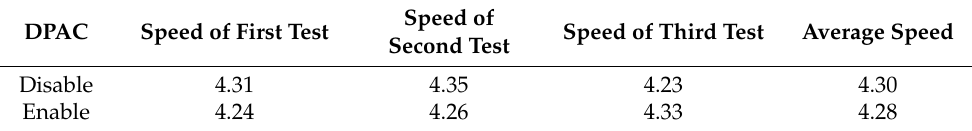
Table 6. Speed comparison